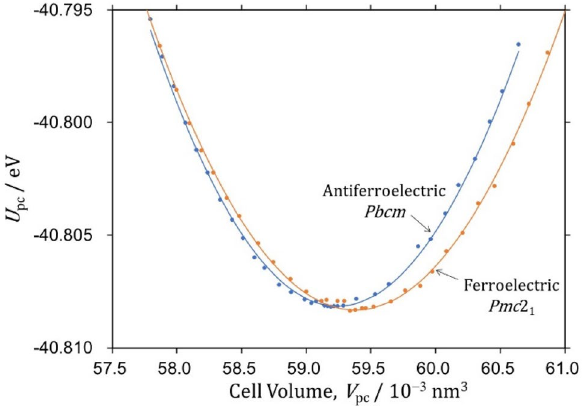
Figure 7. Pseudocubic total energy ( U pc ) per the ABO 3 formula unit as a function of pseudocubic unit cell volume ( V pc ) for the AFE-P phase ( Pbcm ) and the FE-Q phase ( Pmc 2 1 ). The hydrostatic pressure ( p ) changes between −2.8 GPa and 2.8 GPa. Filled circles indicate the data obtained by DFT calculations and solid lines the fitting curves obtained by a nonlinear least square method using Eq. (3).